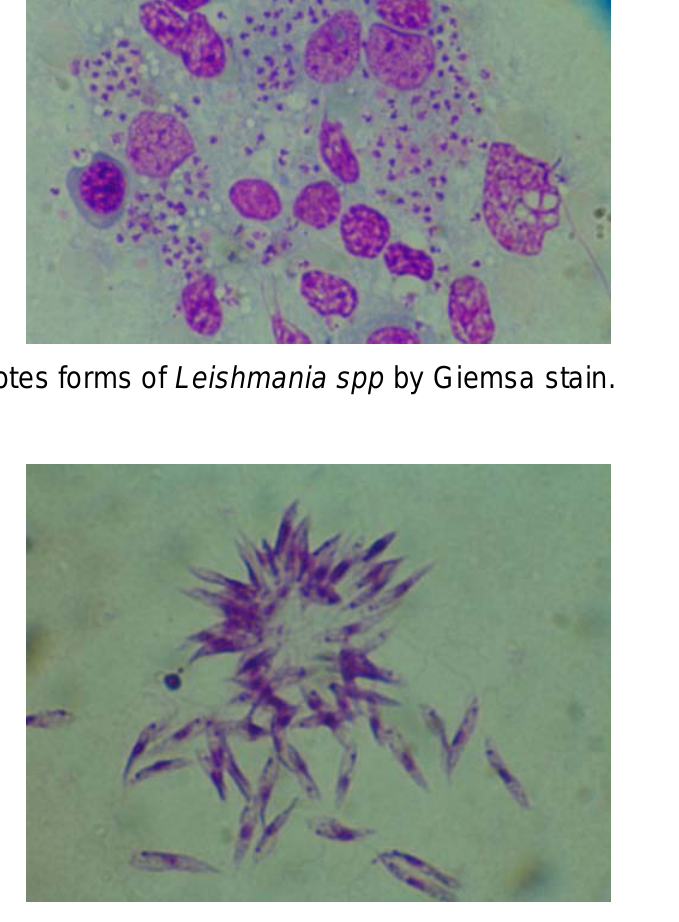
Figure 6. Promastigote forms of Leishmania spp isolated in LIT (Liver Infusion Tryptose) culture medium stained with